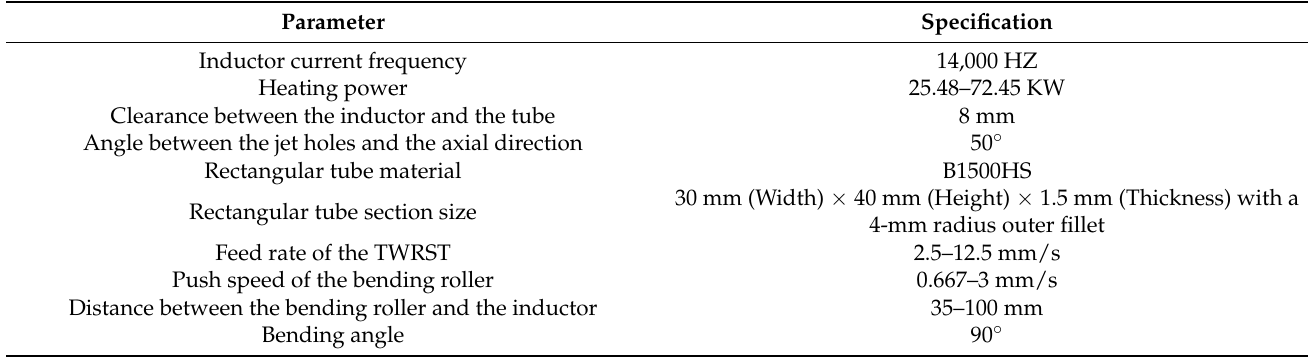
Figure 6. Local-induction-heating bending equipment. Table 3. Experimental